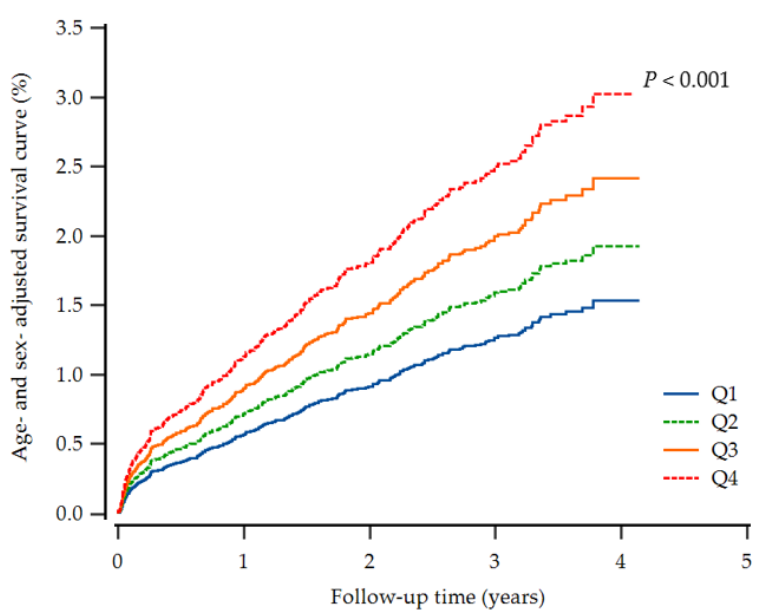
Figure 2. Cox regression survival curve for new-onset ischemic heart disease. Table 3. Hazard ratios (95% confidence intervals) for incident ischemic heart diseases according to sex-specific UHR.